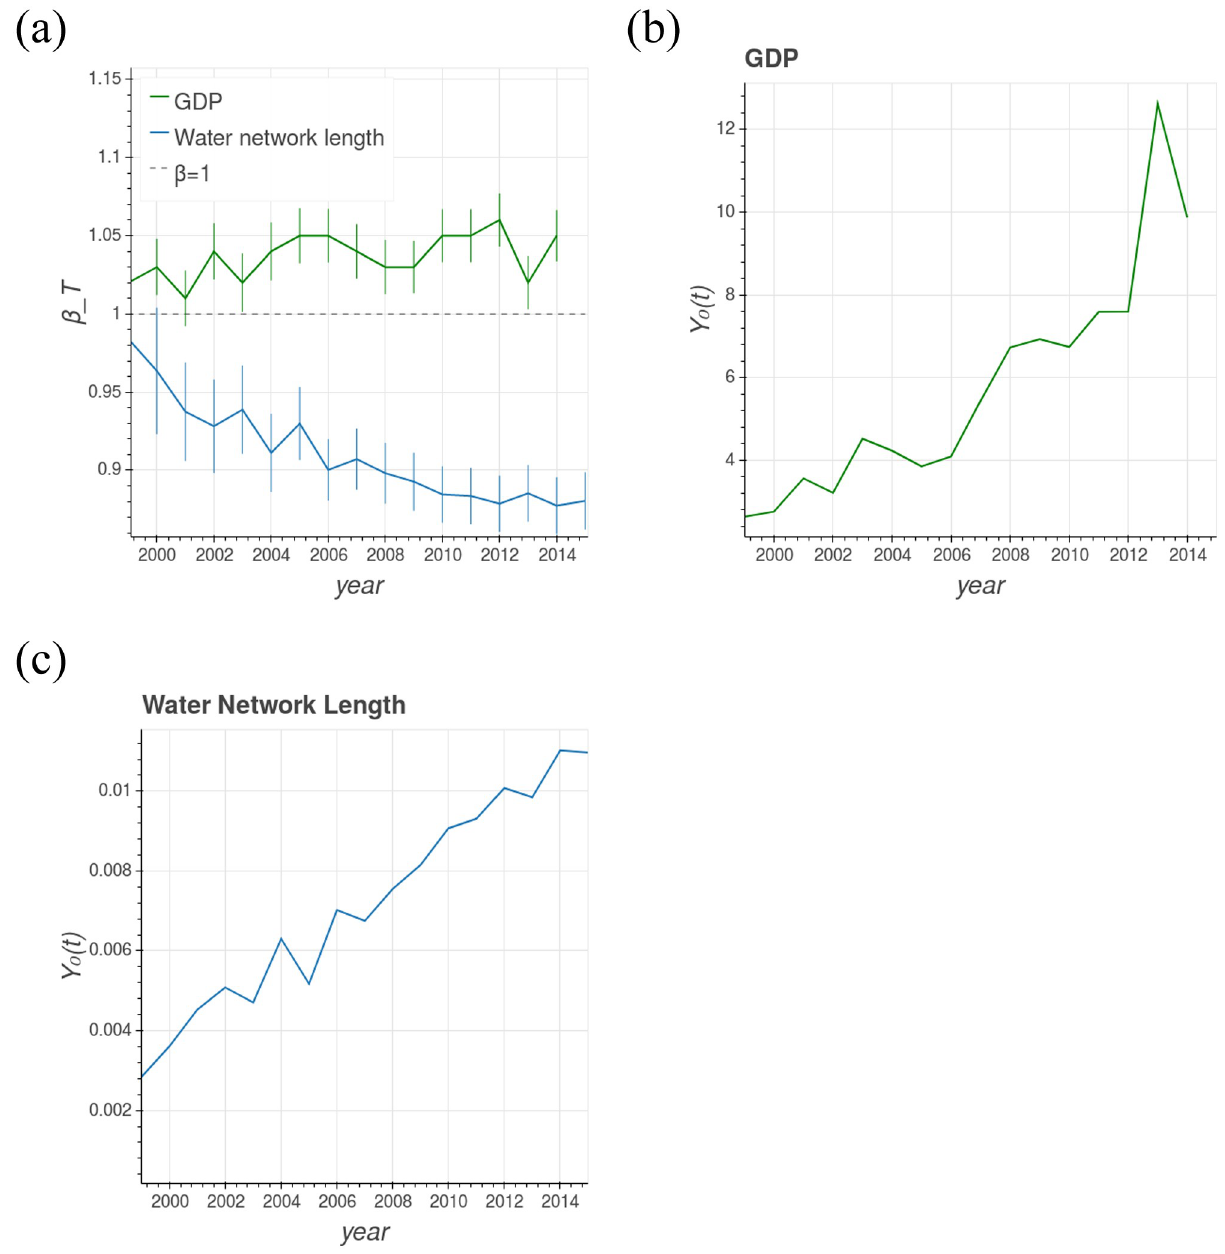
Fig 2. Time evolution of transversal scaling. a) Time evolution of the transversal scaling exponent β for the GDP (green) and water supply network T length (blue) for Brazilian cities. In the GDP case, there is no significant change of this parameter over the years and the regime (superlinear) is always sustained. In the case of water supply network length, β is always smaller than 1, which is expected, given the infrastructure nature of this metric, and it T is decreasing over time. b) and c) present the time evolution of the intercept parameter Y 0 ( t ) for GDP and water supply network length, respectively. The intercept parameter is constantly growing for both urban